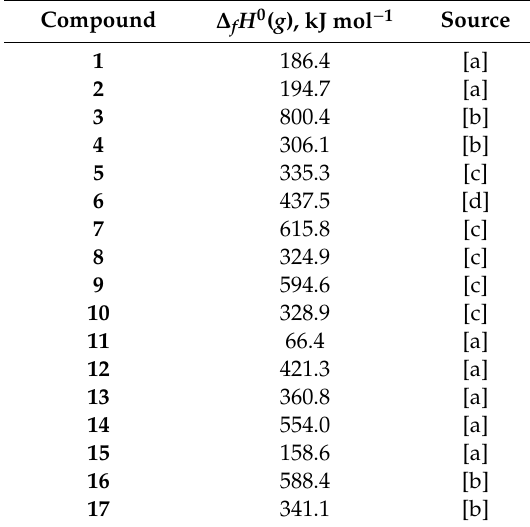
Scheme 5. The isodesmic reactions employed in the present work to calculate the formation enthalpies ∆ 0 ( g ) of the species 5 – 10 and 19 . Table 1. Summary of the most reliable gas-phase formation enthalpies at 298 K ( ∆ f H 0 ( g )) of furoxan and its derivatives ( 1 – 27 , Figures 2, 3 and 9, Schemes 1–4), calculated using W2-F12 and W1-F12 multilevel procedures along with the atomization energy approach and domain-based local pair natural orbital (DLPNO)-CCSD(T) / aVQZ values of the enthalpies of isodesmic reactions. All values are given in kJ mol − 1 .